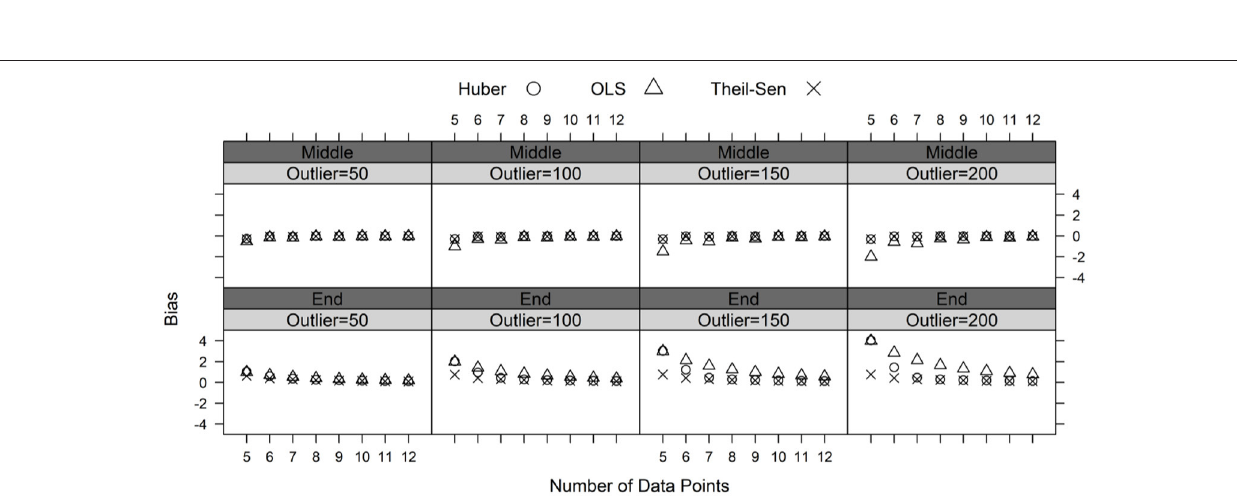
FIGURE 3 | Bias for the estimated slopes by the magnitude of the outlier (50, 100, 150, and 200 points) and the position of the outlier (middle and end) in the progress monitoring data.